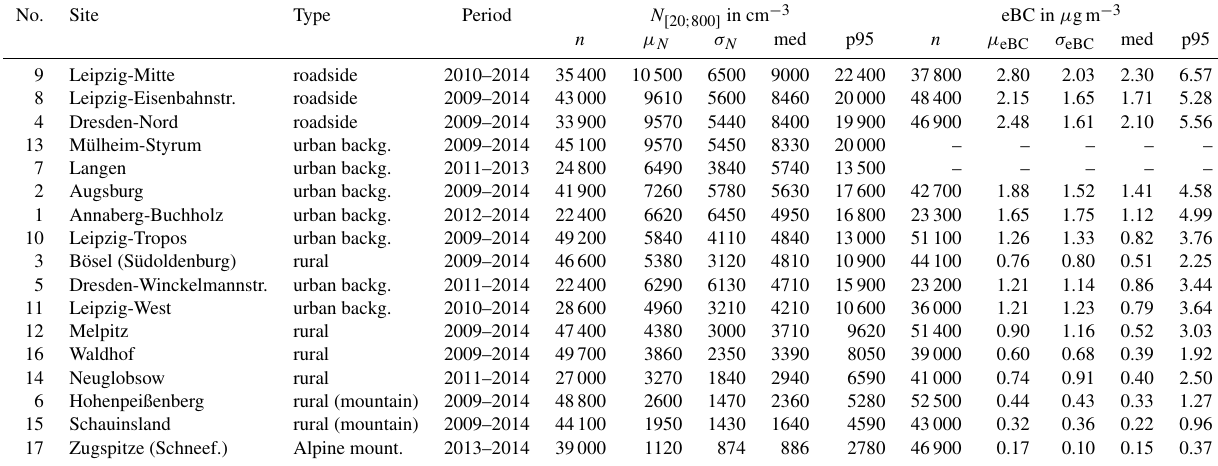
Table 6. Mean values of total particle number concentration ( N [ 20 ; 800 ] ) and eBC mass concentration at 17 GUAN sites. The table indicates the number of hourly samples n , mean value µ , standard deviation σ , median (“med”), and the 95th percentile of the hourly statistics (“p95”). Numbers are indicated at a precision of three significant digits. The stations are sorted according the decreasing median of N [ 20 ; 800 ] .